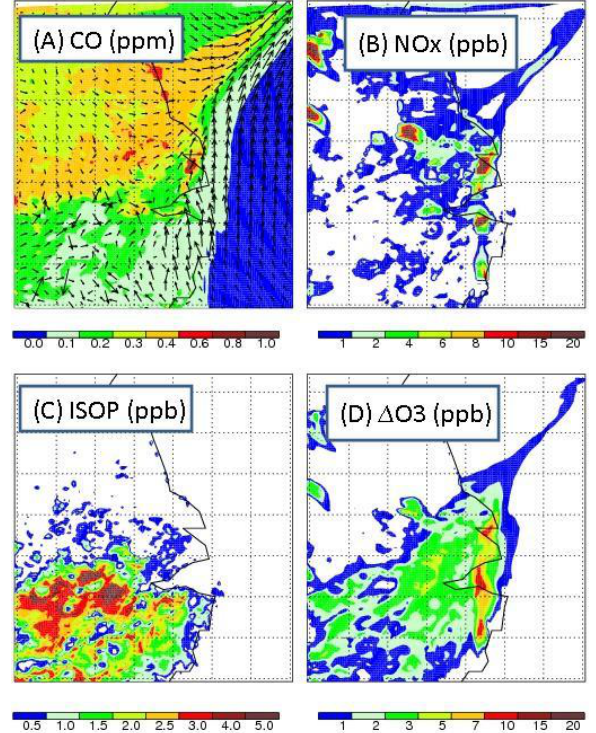
Fig. 6. The calculated CO, NO x , and isoprene concentrations at Figure 6, The calculated CO, NOx, and isoprene concentrations at 12:00 pm of July 12. Panel D shows the calculated changes in O 3 concentrations due to the forest 12:00p.m. of 12 July. (D) shows the calculated changes in O 3 con- isoprene emissions by calculating the difference between RUN-0 and RUN-1. centrations due to the forest isoprene emissions by calculating the difference between RUN-0 and